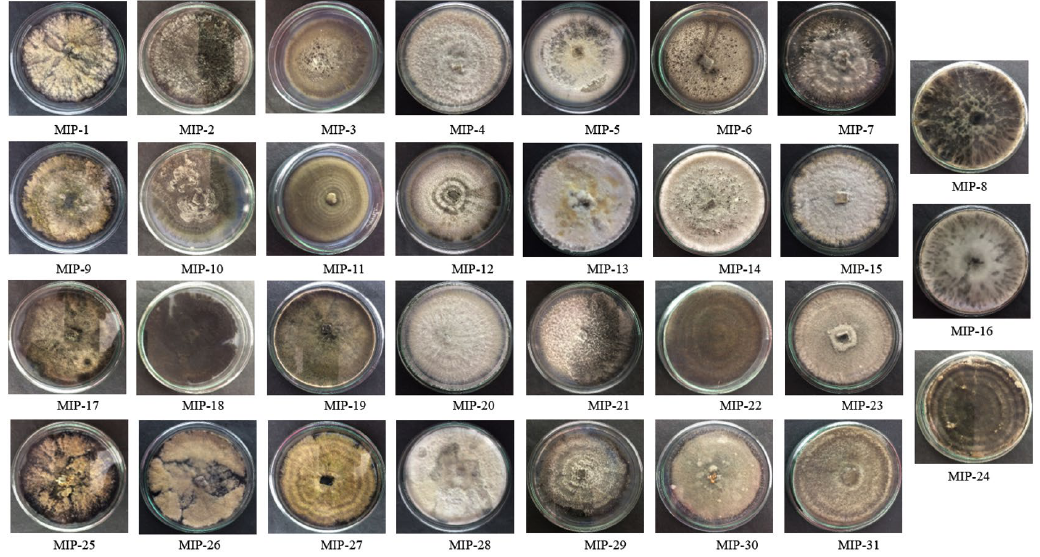
Fig. 1. The culture morphology of 31 endophytic fungal isolates recovered from Mangifera indica